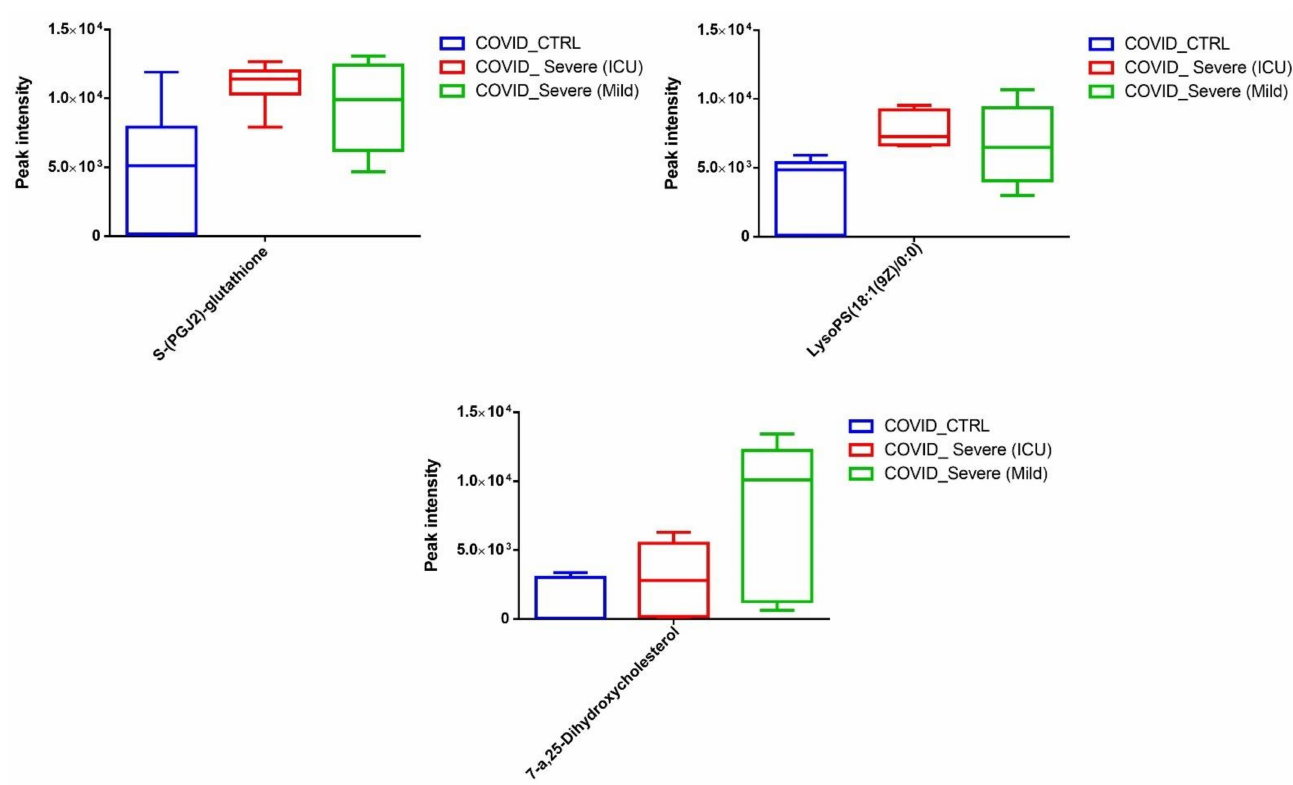
Figure 6. Quantitative levels of LysoPS, 7- α ,25-Dihydroxycholesterol, and 15-d-PGJ2 in COVID-19 EVs when compared to healthy control samples.